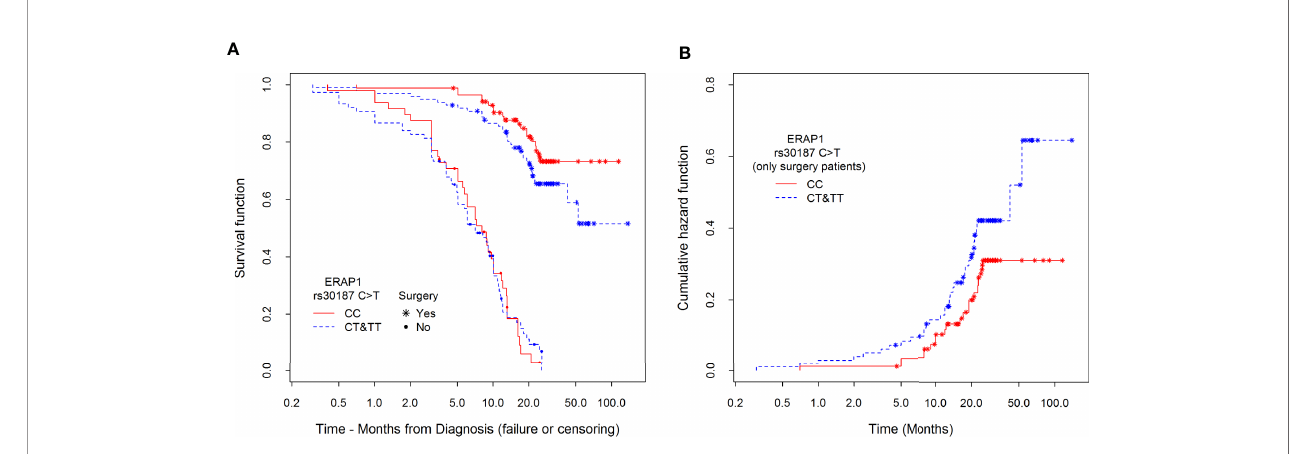
FIGURE 4 | Kaplan – Meier estimators of (A) survival functions among patients divided according to type of treatment (surgery or not) and polymorphism rs30187 in ERAP1 gene and (B) cumulative hazards depending on the polymorphisms only among surgical patients. Hazard risk HR ERAP 1 rs30187C >T = 1 : 46 ( p = 0 : 0972) for differences between CC and CT&TT groups. Estimation of this effect is adjusted to sex, stage of NSCLC, type of treatment, age at diagnosis, and smoking